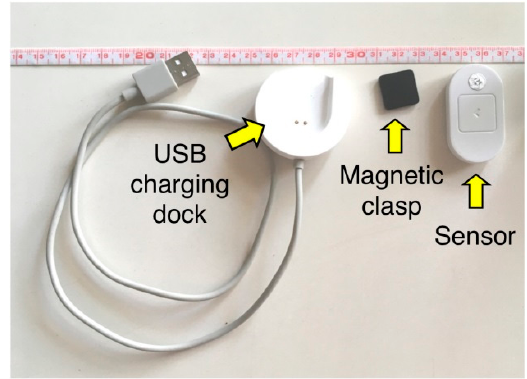
Figure 1. The wearable biofeedback sensor used in this study.